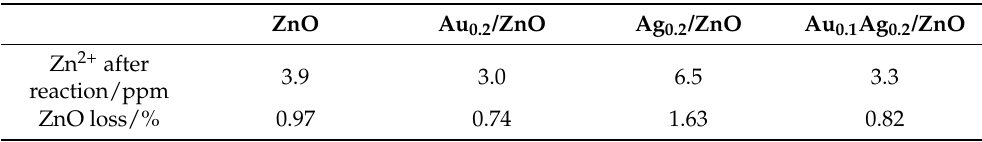
Table 2. The photocorrosion of different ZnO catalyst.